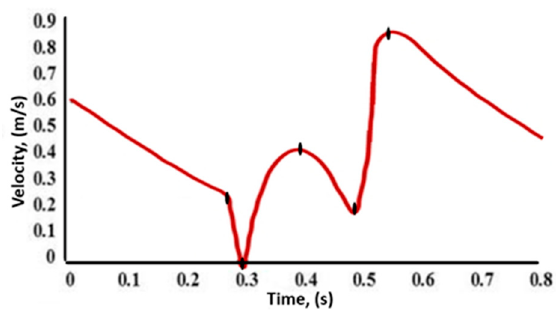
Figure 2. Inlet pulsatile blood flow in the left coronary artery (LCA) model [20].